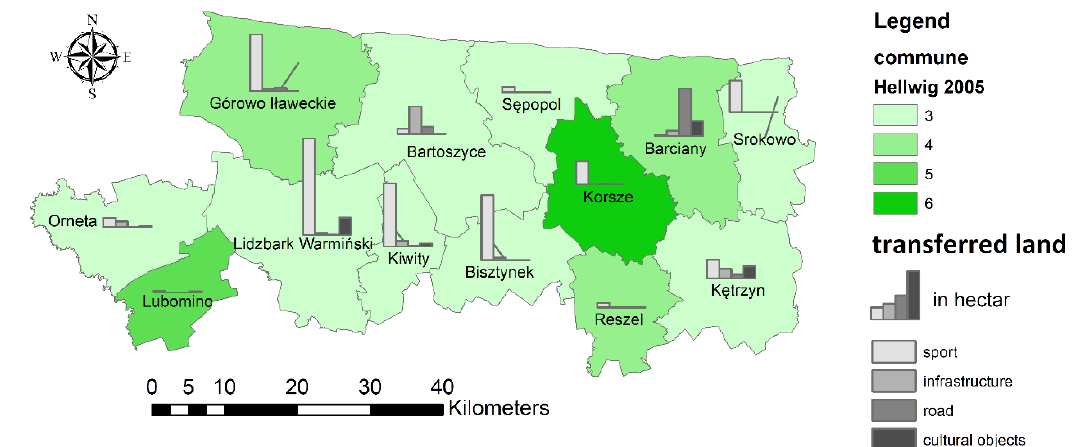
Figure 7. Social development classes for 2005 in comparison with the area of land transferred for various purposes. Data for communes.